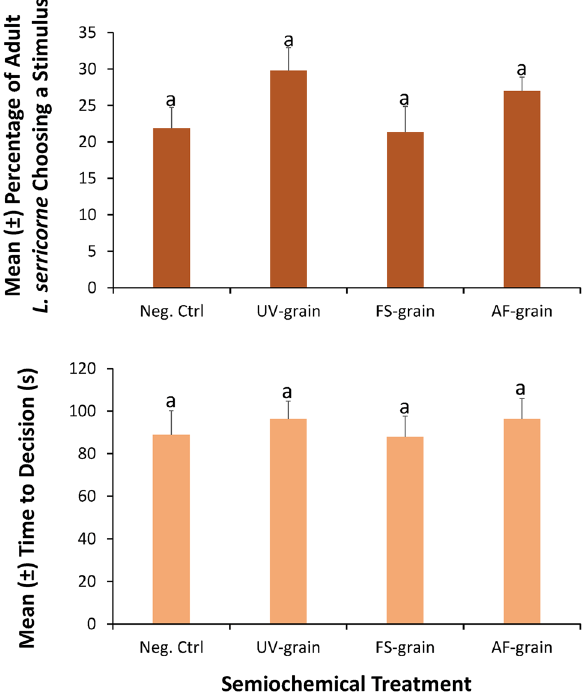
Figure 1. Preference shown in the four-way, still-air olfactometer using the mean percentage of L. serricorne adults choosing a stimulus (± SE) after given a 4-min opportunity (top panel) and their mean time to decision (± SE, s; bottom panel) based on the semiochemical treatment to which they were exposed in the laboratory at the USDA-ARS Center for Grain and Animal Health Research in Manhattan, KS. A total of n = 200 adults replicate were tested in this assay. Bars with shared letters are not significantly different from each other (Tukey HSD, α = 0.05). Neg. Ctrl, negative control; UV-grain, UV-sanitized grain; P. Ctrl, uninoculated grain; FS-grain, F. verticillioides -inoculated grain; AF-grain, A. flavus -inoculated